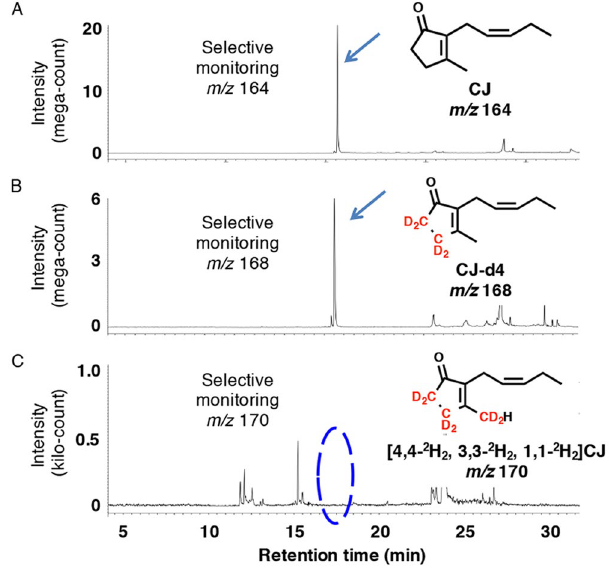
Figure 8. Representative GC MS/MS chromatograms analyzing fungal derived. CJ, CJ-d4, and CJ-d6 using iso -OPDA-d8 as a substrate for a feeding experiment. ( A ) Representative GC-MS chromatogram for measuring fungal derived CJ using selected ion monitoring at m / z 164. ( B ) Representative GC-MS chromatogram for measuring fungal derived CJ-d4 using selected ion monitoring at m / z 168. ( C ) Representative GC-MS chromatogram for measuring fungal derived CJ-d6 using selected ion monitoring at m / z 170. Representative MS chart of the peak indicated by arrow is given in Figure